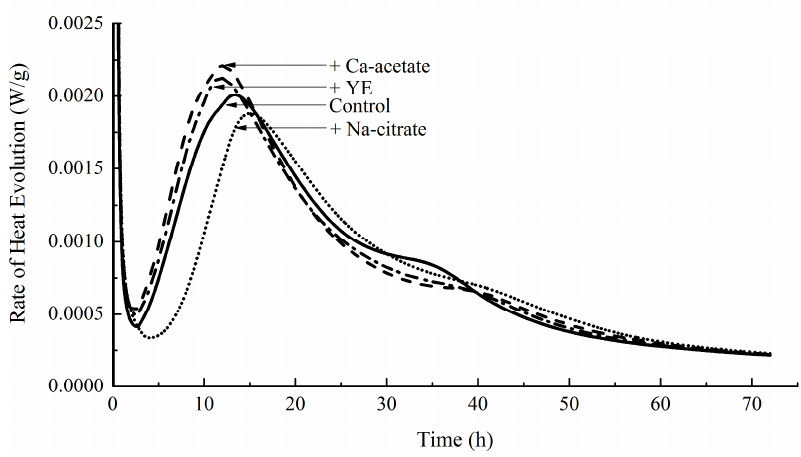
Figure 8 . Hydration kinetics of cement paste containing Ca-acetate (0.28% of the mass of cement), yeast extract (0.06% of the mass of cement), and Na-citrate (0.09% of the mass of cement).